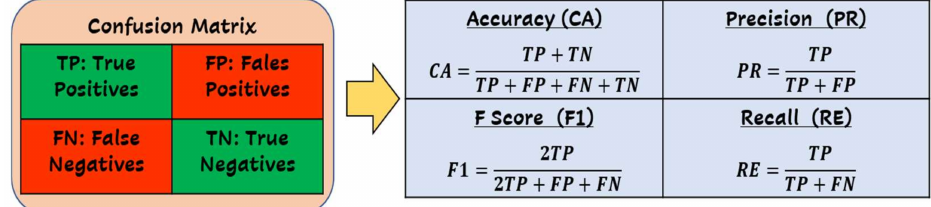
Figure 6. Standard performance assessment